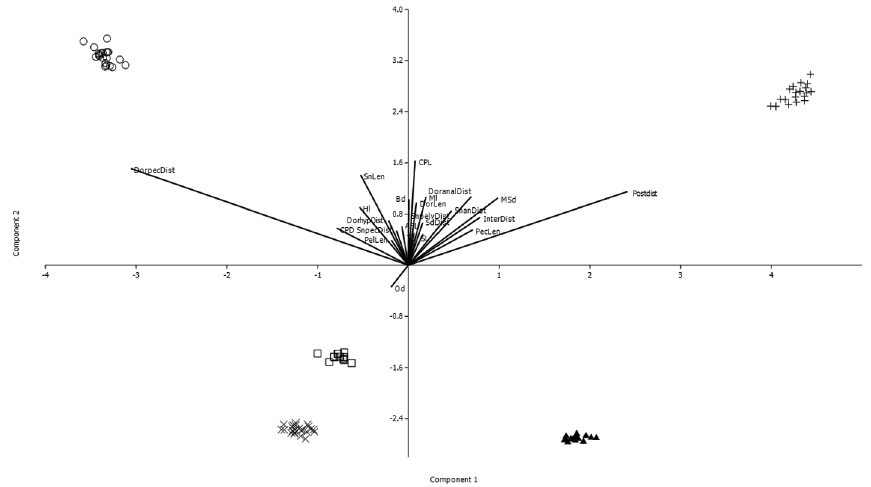
Figure 5. Principal component analysis for morphological data of Hyphessobrycon klausanni sp. n. ( □ ), H. acaciae (+), H. mavro ( ▲ ), H. metae ( ○ ) and H. niger (x); component 1 on X axis and component 2 plotted on Y axis. Abbreviations same as Table